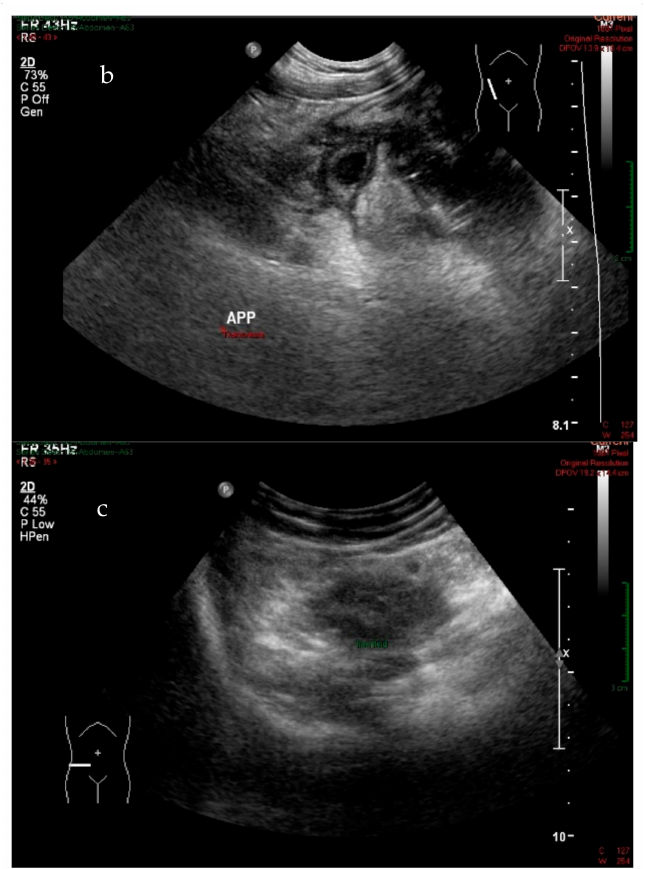
Figure 4. Longitudinal ( a ) and transverse ( b ) real-time ultrasound scan of acute appendicitis with diameter > 7 mm (white measure) and wall thickness 2.6 mm (green measure) for 33-year-old male patient with pain in the right lower quadrant; transverse ( c ) real-time ultrasound scan for 34-year-old female patient with suspected appendicitis shows free fluid in the right lower